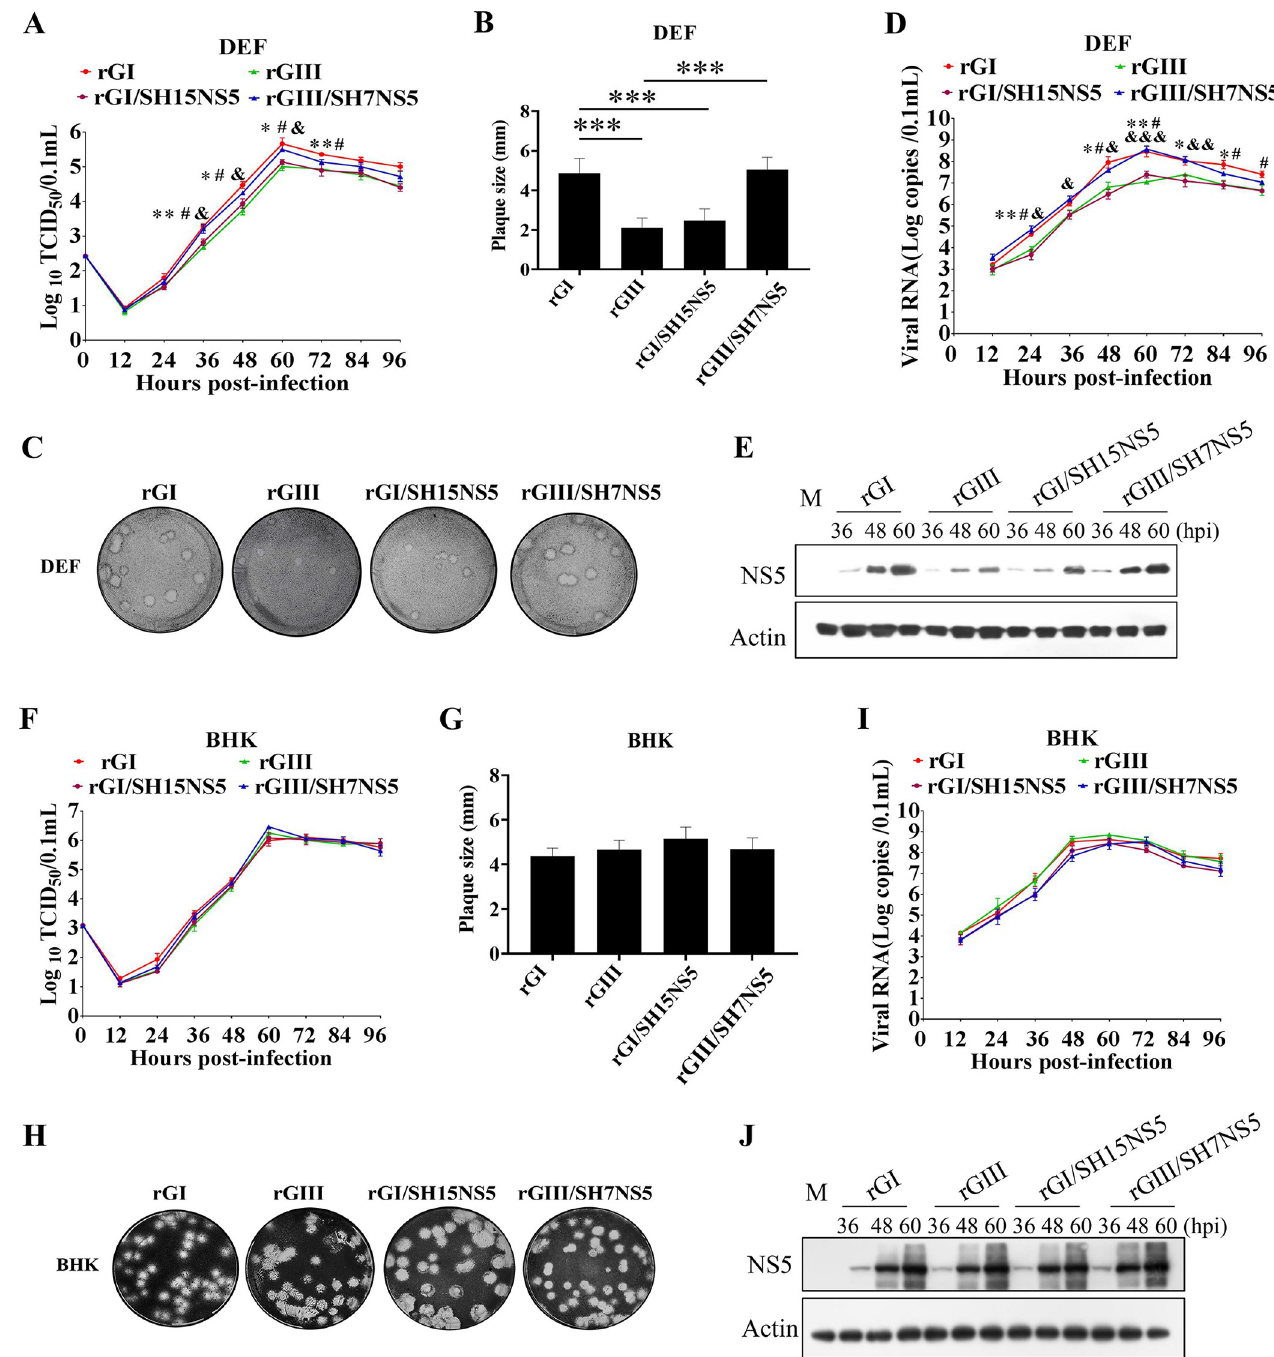
Fig 5. Replication efficiency of chimeric viruses with substitution of NS5. (A, D and E) DEF were infected with the indicated chimeric viruses and the respective parental viruses at 0.01 MOI and collected at the indicated time points for analysis of replication efficiency. The replication titers in the supernatants were titrated with TCID 50 assays in BHK cells (A). The viral RNA copies and NS5 levels in the cells were examined with TaqMan probe-based qRT-PCR (D) and western blotting with anti-NS5 antibodies (E), respectively. All data are presented as mean ± SD from three independent experiments and were tested by Student’s t -test. The significant differences between rGI and rGIII at different time points are labeled ( � , p < 0.05; �� , p < 0.01). The significant difference between rGI and rGI/SH15NS5 at different time points is marked (#, p < 0.05). The significant difference between rGIII and rGIII/SH7NS5 at different time points is indicated (&&&, p < 0.001; &&, p < 0.01; &, p < 0.05). (B, C, G and H) Monolayers of DEF (B and C) or BHK cells (G and H) were infected with the indicated chimeric viruses and the respective parental viruses at 100 PFU for analysis of plaque morphology. The plaques were stained with crystal violet at 4 dpi (C and H) and the plaque diameters were measured and plotted (B and G). The significant differences between groups were tested by Student’s t -test ( ��� ,